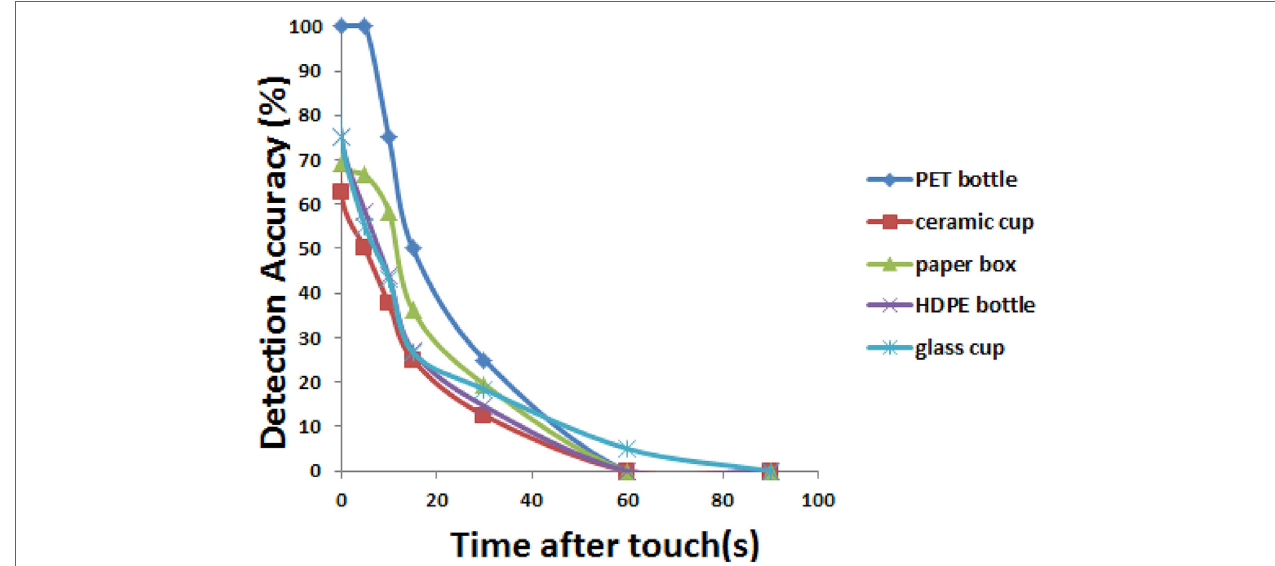
FigUre 11 | Accuracy of detecting touches to objects, by material and